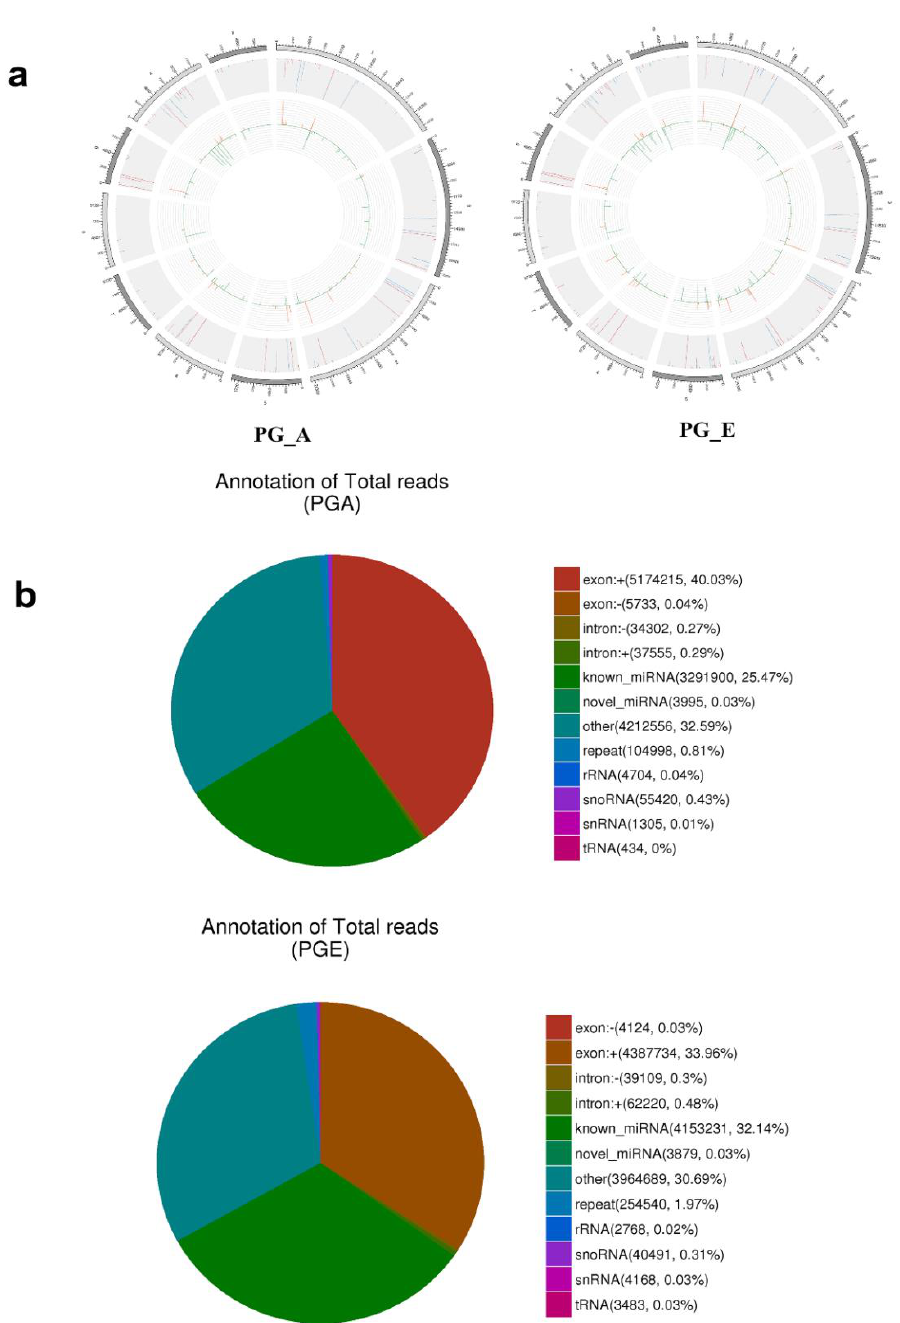
Figure 2. Distribution and annotation of miRNAs on chromosomes. ( a ) Distribution of miRNAs on chromosomes. Outermost circle is the chromosomes designated to display. Gray background region in the center is the distribution of 10,000 reads; red is mapped to the positive side chain; blue is mapped to the negative side chain; orange is positive chain distribution; and green is negative chain distribution. ( b ) Small RNA classification annotations.